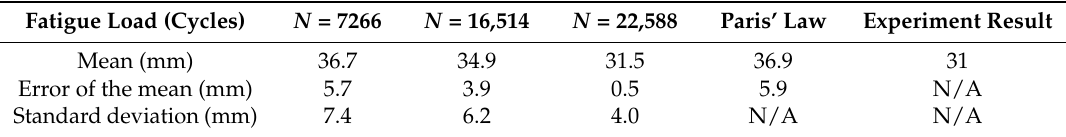
Figure 16. The crack propagation prognosis of the specimen T 3 at: ( a ) N = 7266; ( b ) N = 16,514; ( c ) N = 22,588 cycles. Table 8. The prognostic crack length of the specimen T 3 for N = 26,091 cycles.